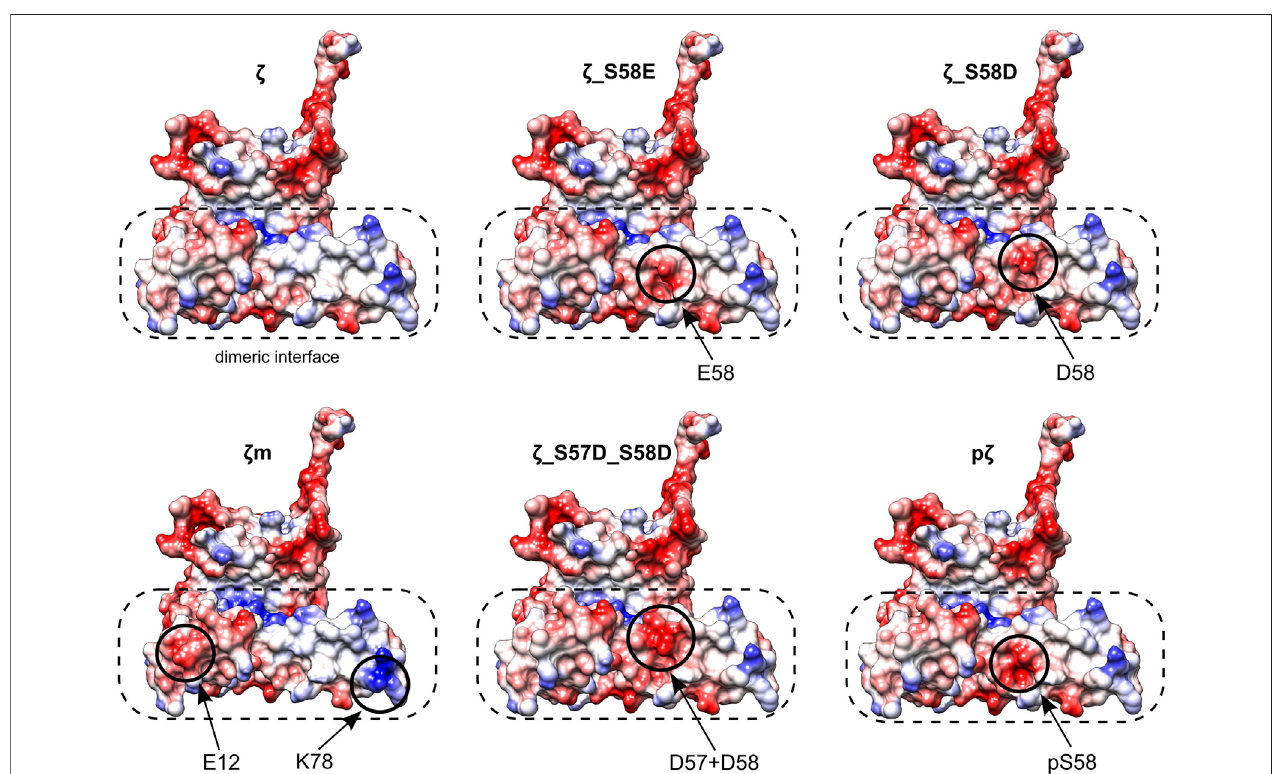
FIGURE 7 | Electrostatic potential maps of all 14-3-3 ζ variants. Only monomeric subunits are shown. Modi fi cations and corresponding changes in charge distributions at the dimeric interface (in a dashed rectangle) are highlighted (in solid circles). Negative electrostatic potential is depicted in red, positive in blue. Atom coordinates of the 14-3-3 ζ were adopted from Kostelecky et al. (2009) and Nagy et al. (2017). The desired residues were mutated in silico and their conformations were selected from a library of possible conformers. Mutagenesis and generation of the electrostatic potential maps with Coulombic surface coloring were performed in UCSF Chimera (Pettersen et al.,